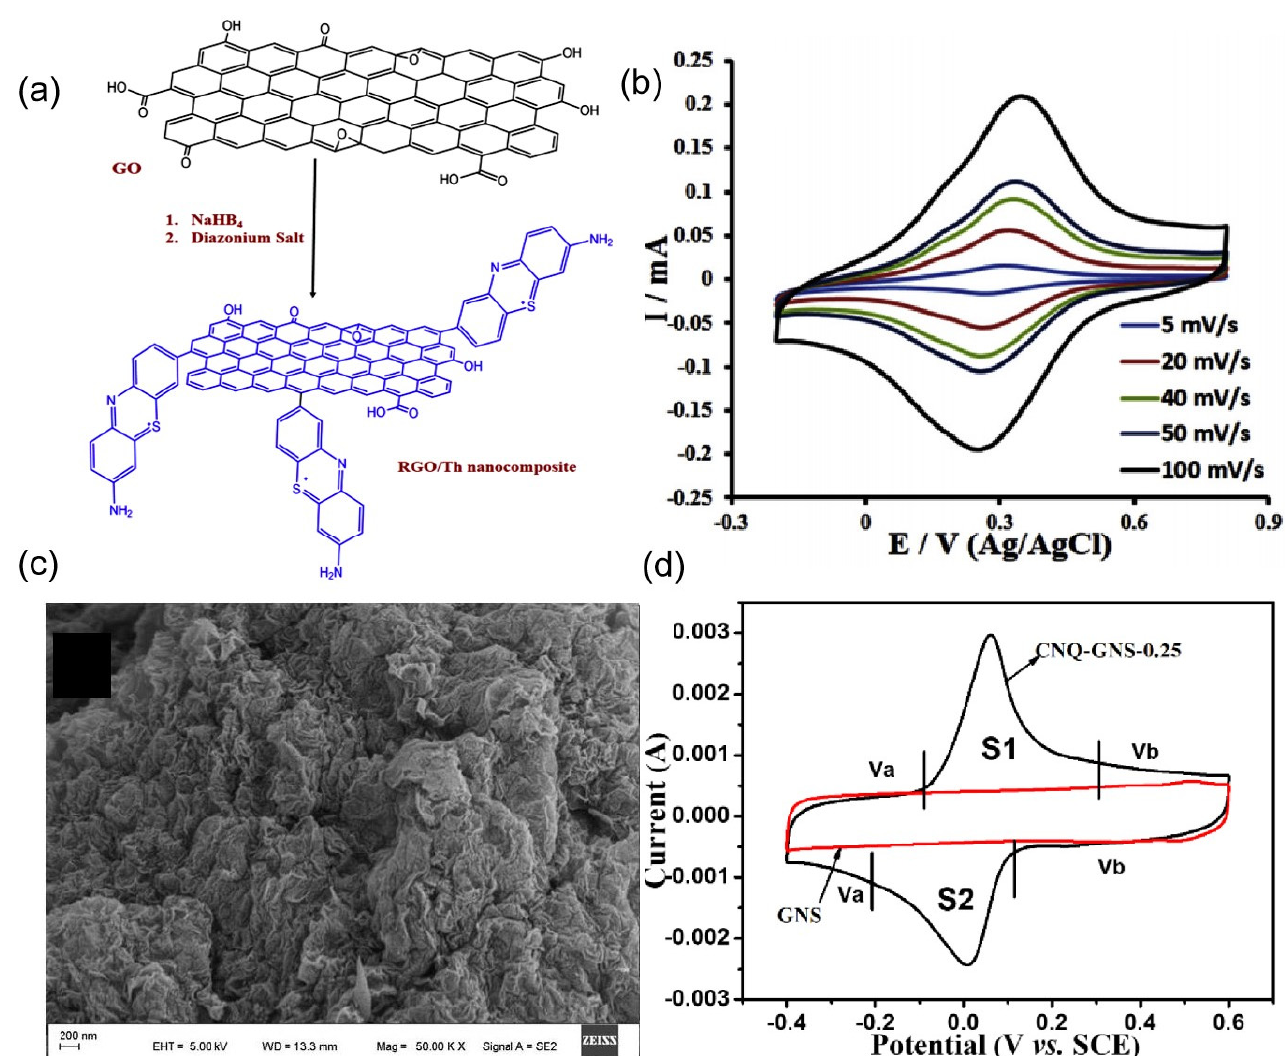
Figure 8. ( a ) Th/rGO nanocomposite synthesis path. ( b ) The CV curves of Th/rGO. Reprinted from [76]. Copyright (2018), with permission from Elsevier. ( c ) The SEM image of CNQ-GNS-0.25. ( d ) The CV curves of CNQ-GNS-0.25 and GNS at a scan rate of 50 mV s − 1 in 1 M H 2 SO 4 . Reproduced from [79] with permission from the Royal Society of Chemistry.